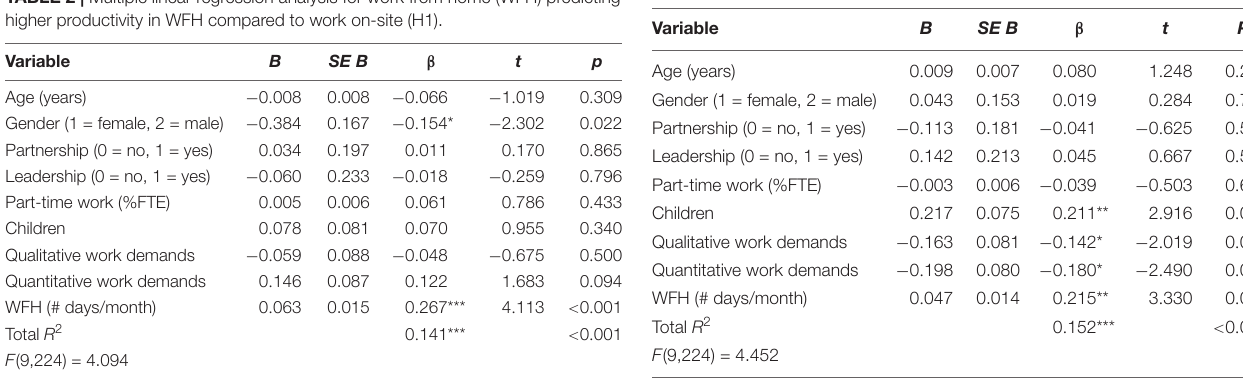
TABLE 4 | Multiple linear regression analysis for work from home (WFH) predicting job satisfaction